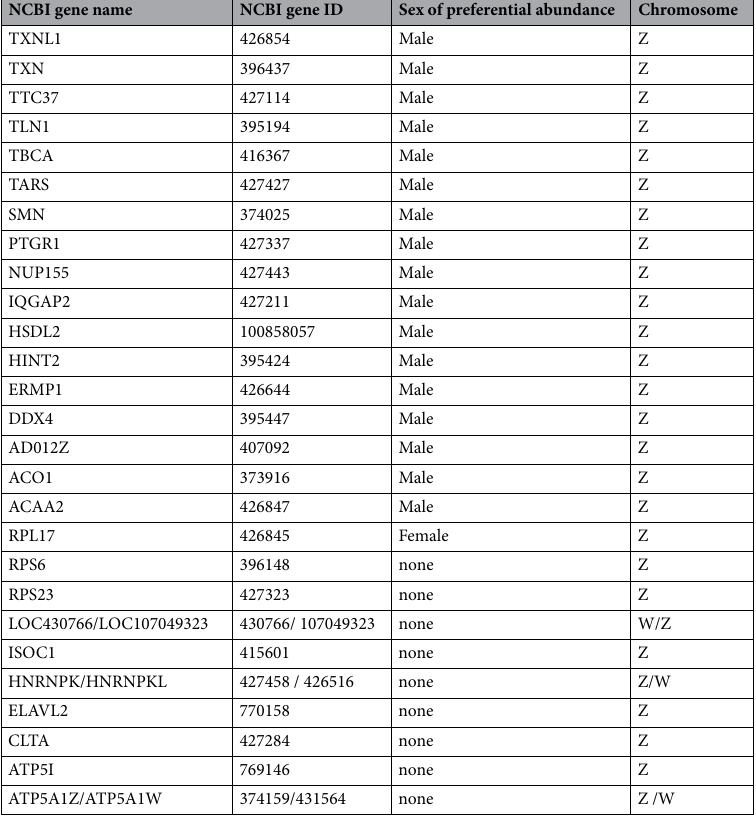
Table 2. List of sex chromosome linked genes encoding proteins identified in cultured in vitro chicken